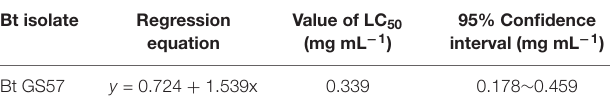
Beijing, China), according to the manufacturer’s instructions.